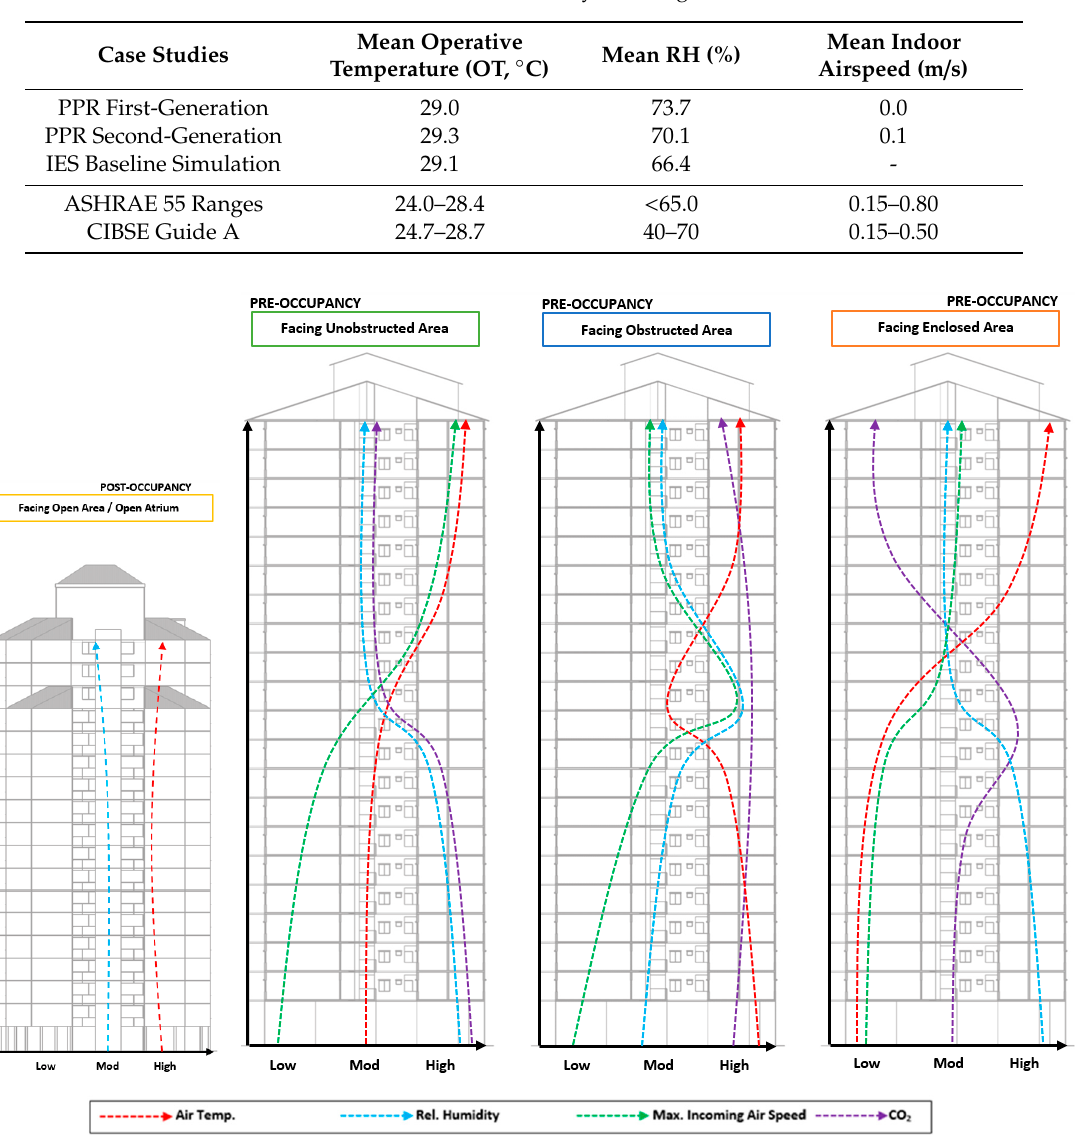
Table 4. Fieldwork study 1 findings.